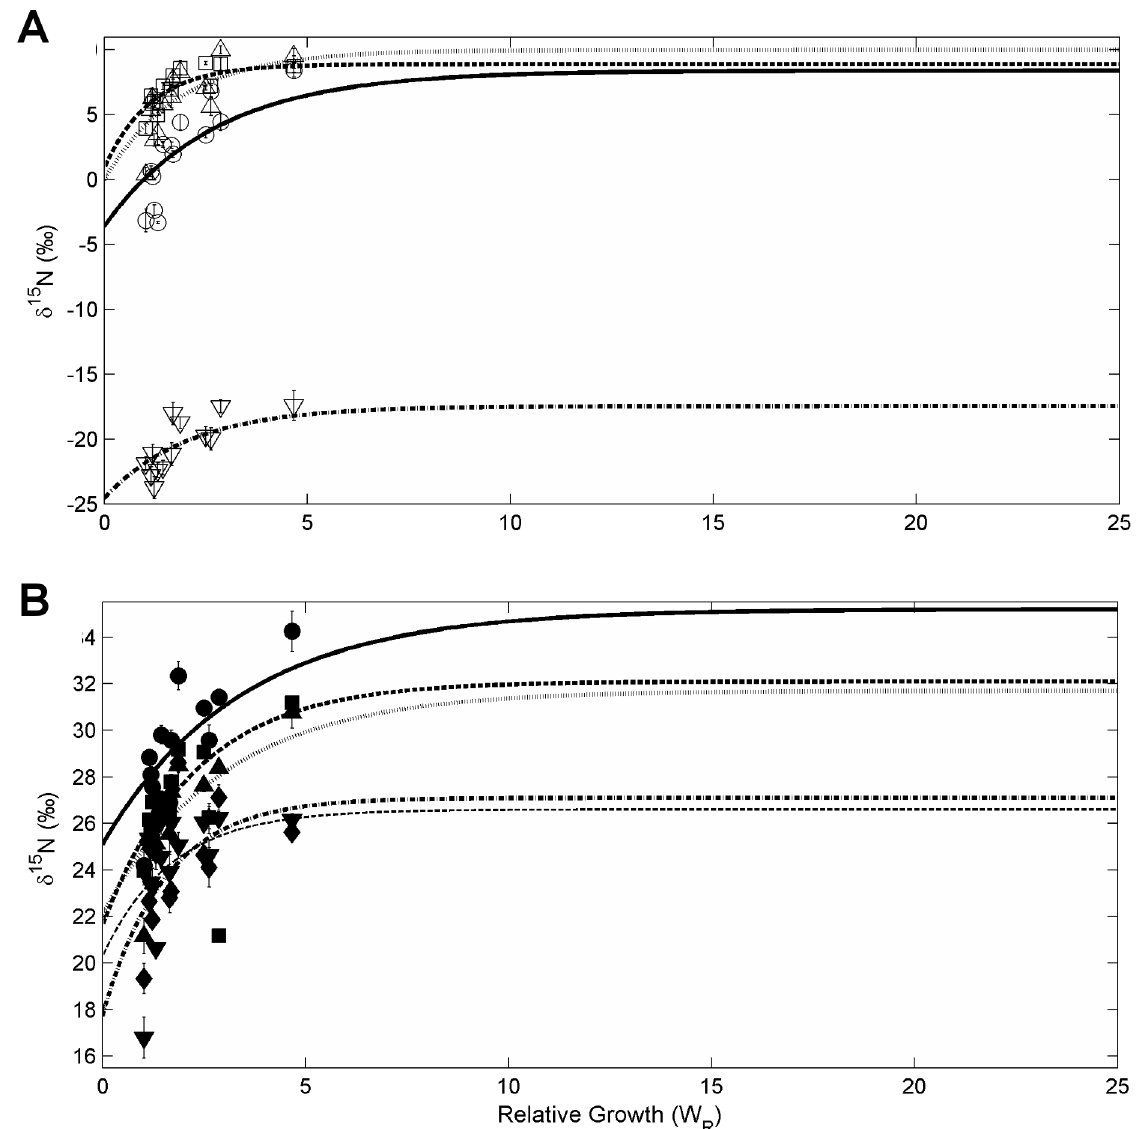
Figure 2. Growth based changes in amino acid isotopic composition in captive Pacific bluefin tuna ( Thunnusorientalis ). Incorporation of 15 N into amino acids of white muscle tissue as a function of relative growth (W R ). A) Four source amino acids, glycine (unfilled circle), lysine (unfilled square), serine (unfilled triangle), threonine (unfilled inverted triangle), and B) five trophic amino acids - alanine (filled circle), glutamic acid (filled square), leucine (filled triangle), proline (filled inverted triangle), and valine (unfilled diamond) are given. Lines represent best fit lines for an exponential fit model.